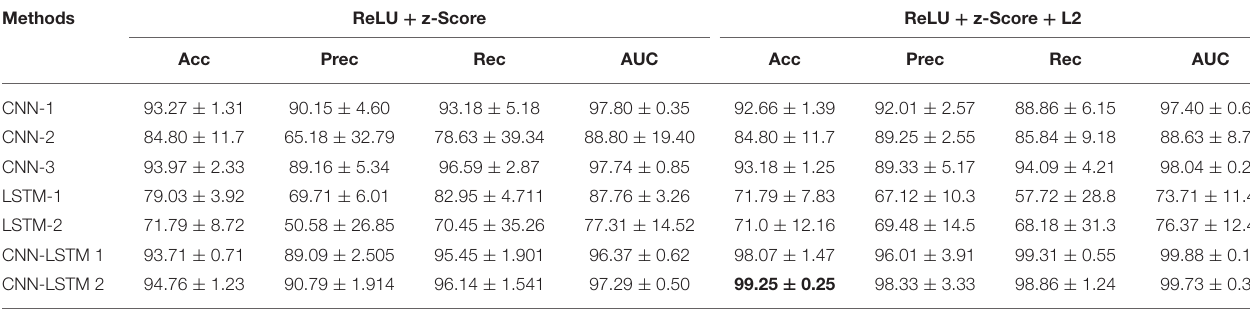
TABLE 12 | Performance criteria of the proposed DL methods with ReLU activation function. Methods